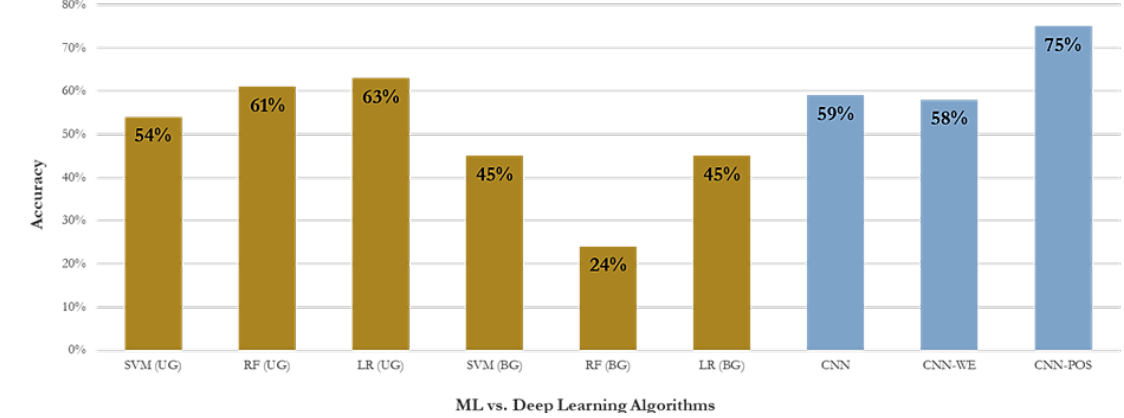
Fig. 10. Accuracy of ML models vs. DL models for the aspect detection phase.